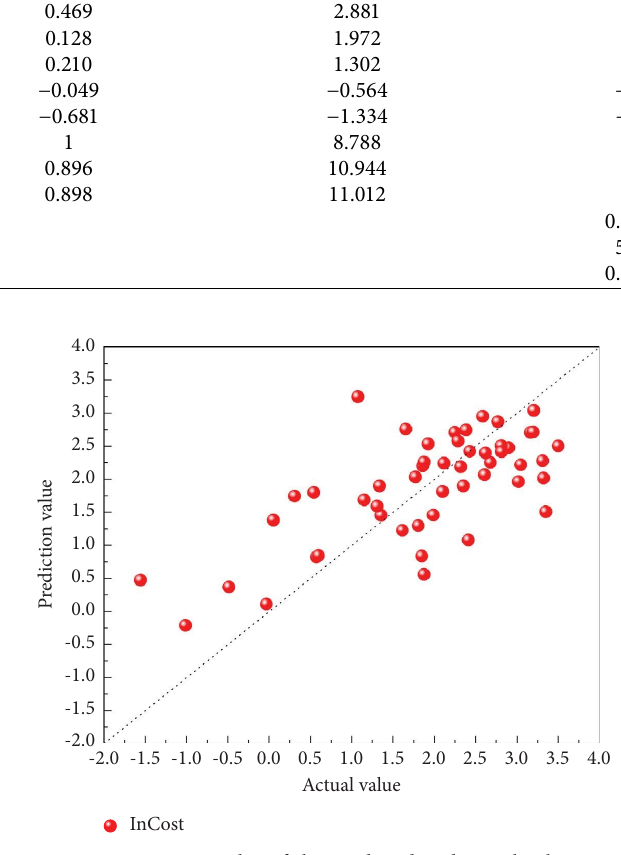
Figure 7: Scatter plot of the predicted and actual